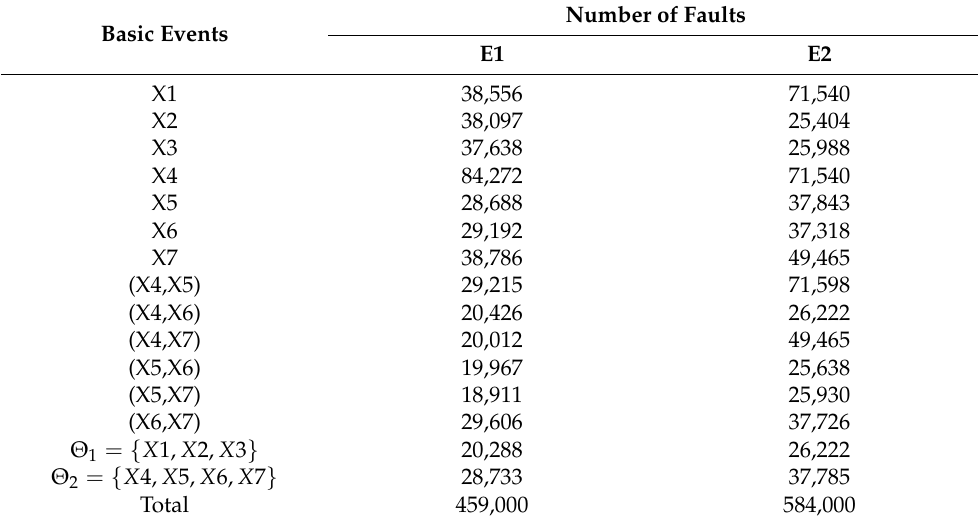
Table 2. Similar product statistics.